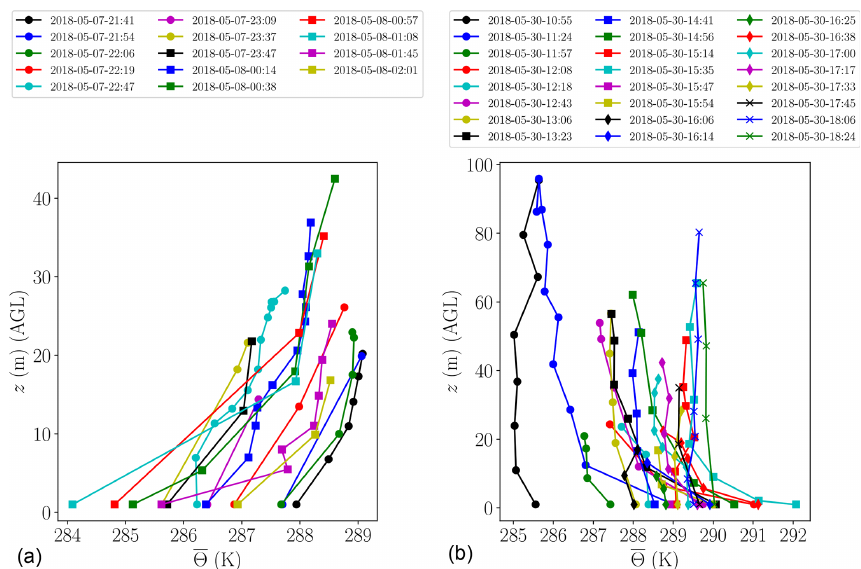
Figure 9. Vertical profiles of potential temperature on 7, 8 and 30 May 2018. (a) Thermally stable condition at night and in the early morning when the gradients are positive near the surface; (b) thermally unstable condition at midday when the gradients are negative near the surface; times are in LDT.